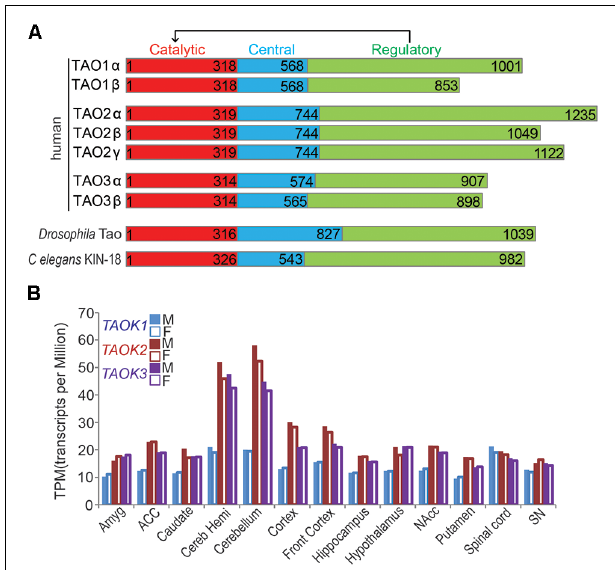
FIGURE 1 | Thousand and one (TAO) kinases are highly conserved. (A) Schematic structure of conserved TAO kinase family is shown. A typical protein structure of TAO kinase includes a catalytic domain, a central domain, and a regulatory domain, which could regulate catalytic activity. In humans, three genes of TAO kinases encoding TAO1, TAO2, and TAO3 are present, each of them has two isoforms ( α and β , except TAO2 has the third putative one γ isoform) which may take different biological functions. Only a single Tao gene is encoded in Drosophila melanogaster ( CG14217 , Tao ) and C. elegans ( kin-18 ). (B) The relative expression levels (TPM) of human TAO kinases in different areas of the central nervous system (CNS) are shown. The bar represents the median value from RNA sequencing. Data source: the Genotype-Tissue Expression (GTEx) project. M, male; F,